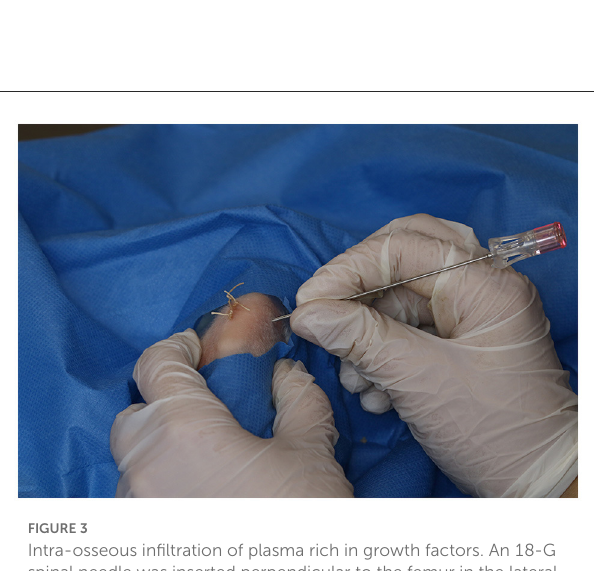
FIGURE3 Intra-osseous infiltration of plasma rich in growth factors. An 18-G spinal needle was inserted perpendicular to the femur in the lateral supracondylar region with gentle rotation movements.